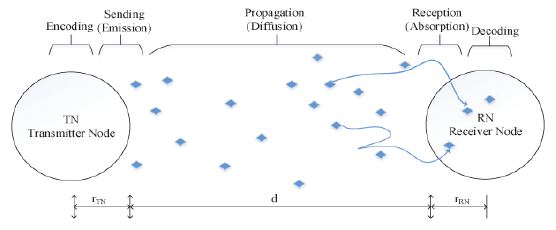
Figure 1: MCvD system model in a 3-D environ- ment[11]